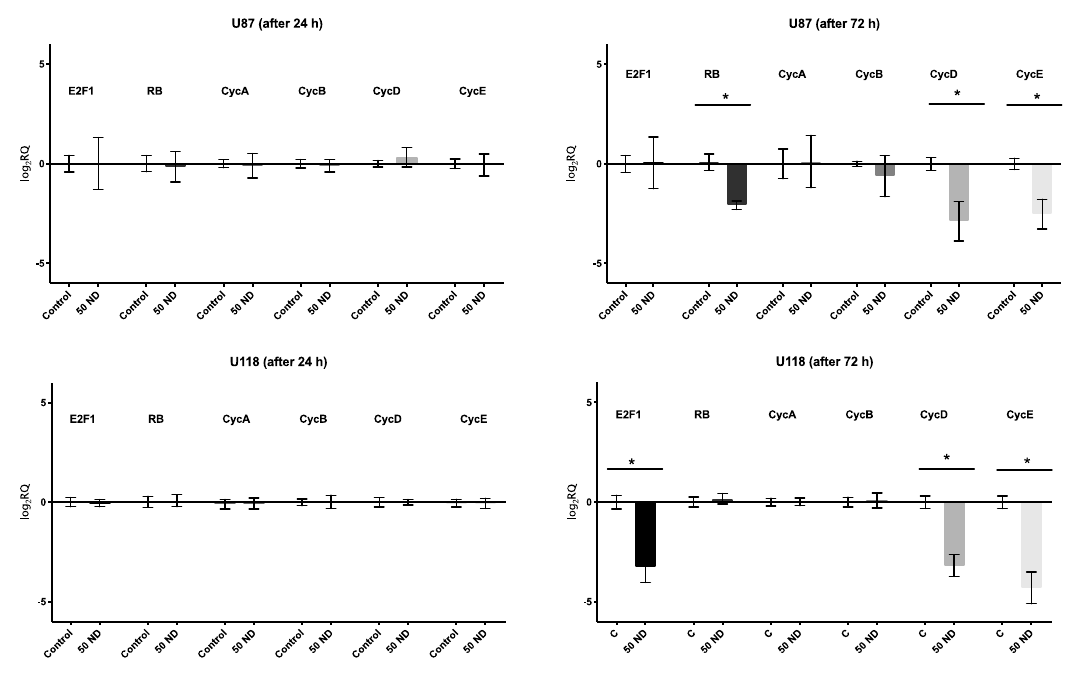
Figure 8. Analysis of the mRNA expression levels of E2F1 , Rb , CycA , CycB , CycD , CycE . The U87 and U118 cells were treated with 50 µ g / mL diamond nanoparticles (NDs) for 24 and 72 h. Groups marked with an asterisk (*) are significantly di ff erent ( p < 0.05). The results are calculated relative to the control values. Log 2 RQ values for all genes are normalized to the TBP housekeeping gene. TBP , TATA-box binding protein; CycA , Cyclin A2; CycD , Cyclin D2; CycB , Cyclin B1; CycE , Cyclin E2; Rb , transcriptional corepressor 1; E2F1 , E2F transcription factor 1; PCNA , proliferating cell nuclear antigen; Ki-67 , marker of proliferation KI-67.